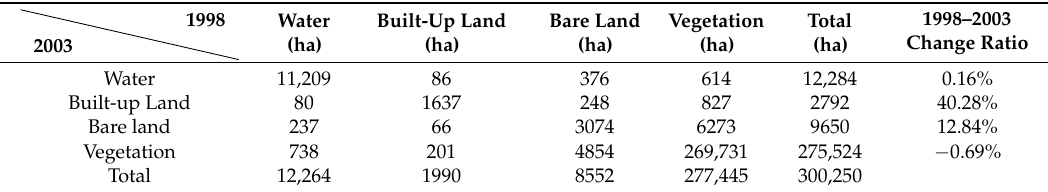
Table 3. Land-cover transfer matrix from 1998 to 2003.